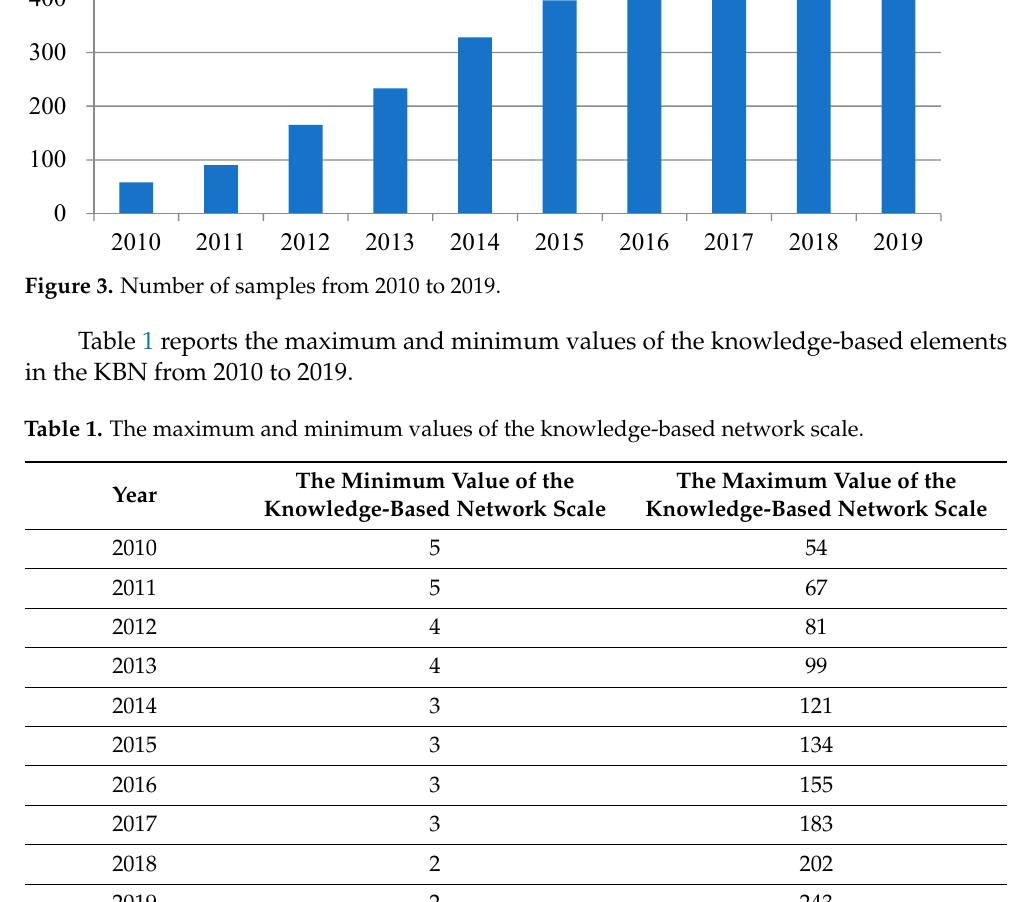
9 of 18 Figure 2. Knowledge-based network visualization of Heng Sheng electronics in 2015 . 5.3. Overview of the Knowledge-Based Network in the Electronic Information Industry